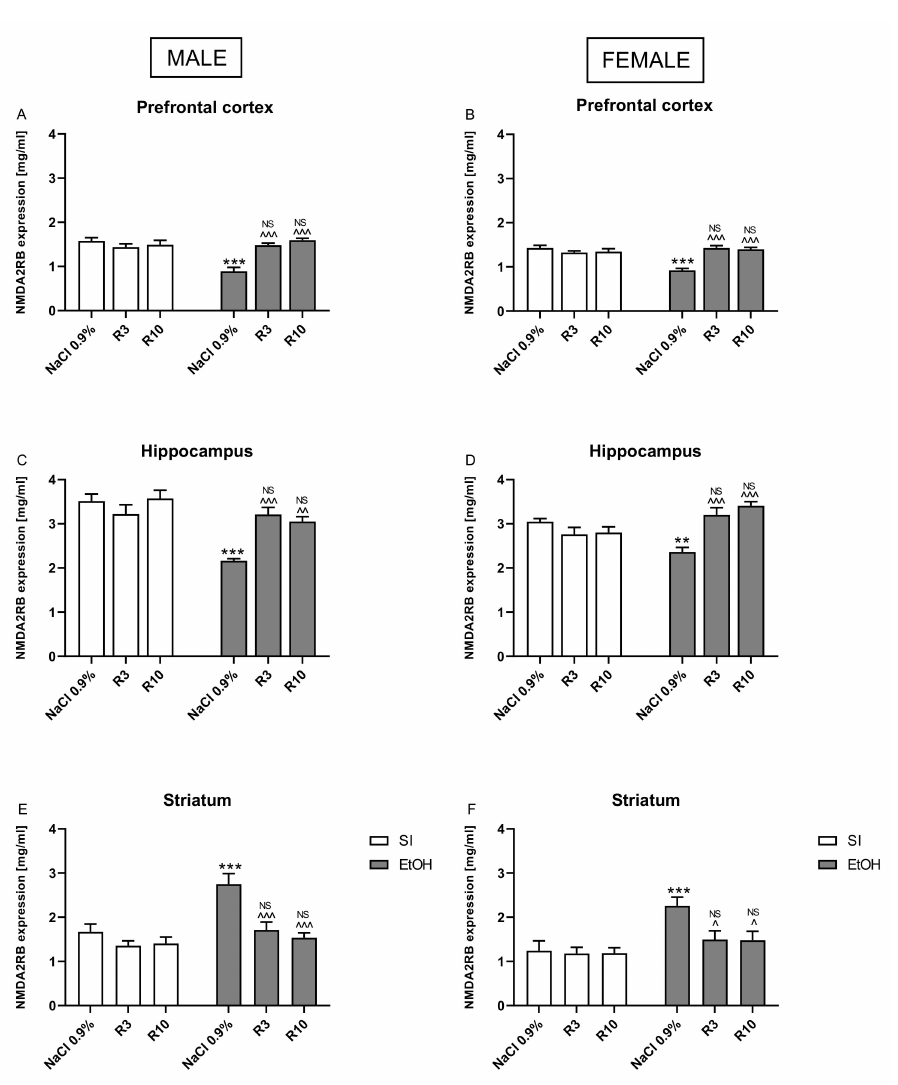
Figure 6. The influence of rapamycin pre-treatment (3 and 10 mg/kg, i.p.) during neonatal period before every ethanol administration (PND4–9) on the expression of GluN2B subunit of NMDA receptor in adult (PND69) male and female rats in the prefrontal cortex ( A , C ) and hippocampus ( B , D ). Striatum: ( E , F ). Results are expressed as mean ± SEM of 8 subjects per group. ** p < 0.01; *** p < 0.001 vs. SI; ˆ p < 0.05; ˆˆ p < 0.01; ˆˆˆ p < 0.001 vs. EtOH. NS–nonsignificant vs. the non-alcohol treated controls; EtOH R3–rapamycin 3 mg/kg; R10–rapamycin 10 mg/kg, SI–shame intubation (i.g.); EtOH–ethanol intubation